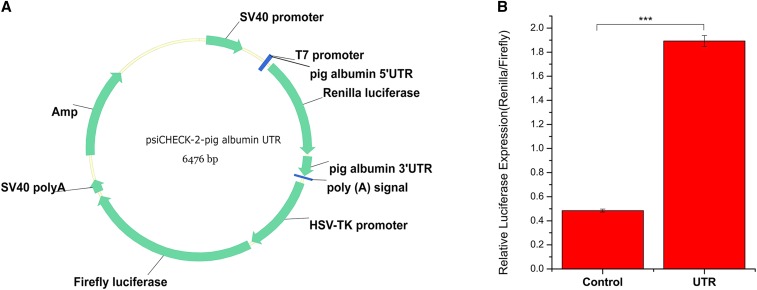
Dual luciferase assays in PK-15 cells. (A) Schematic of the psiCheck-2-pig albumin UTR plasmid; (B) The relative luciferase expression between psiCheck-2-pig albumin UTR plasmid transfected cells and control psiCheck-2 plasmid transfected cells. N = 3, *** P < 0.0001.